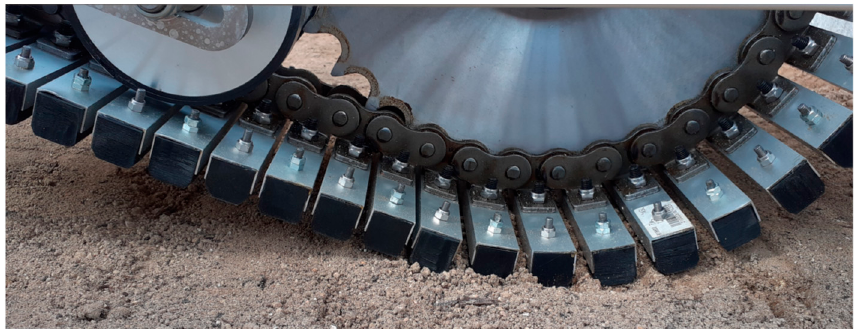
Figure 10. Detailed photo of the track belt.